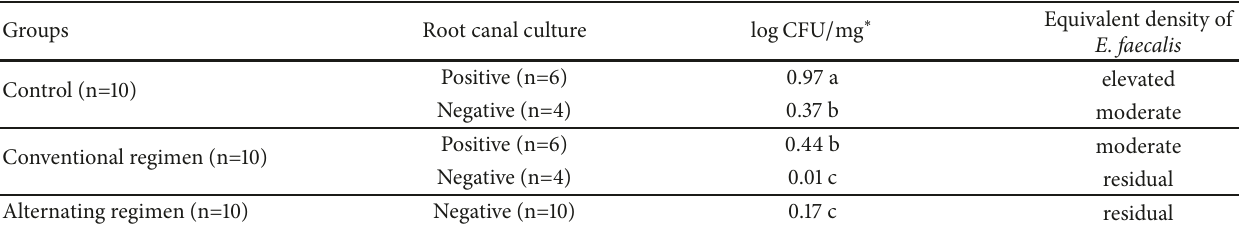
Table 1: Intracanal microbiological conditions and E. faecalis density in the adjacent dentin in log scale. Groups Root canal